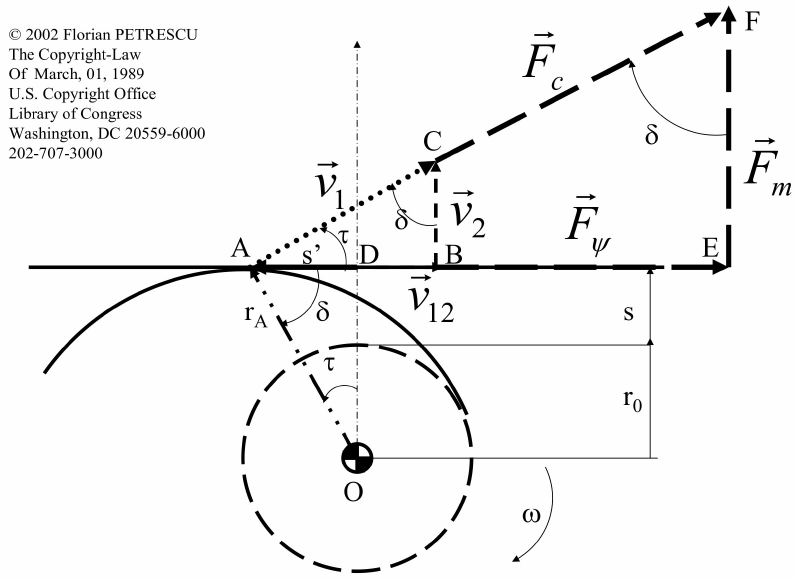
Figure 3. Forces and speeds at the translated dept with the